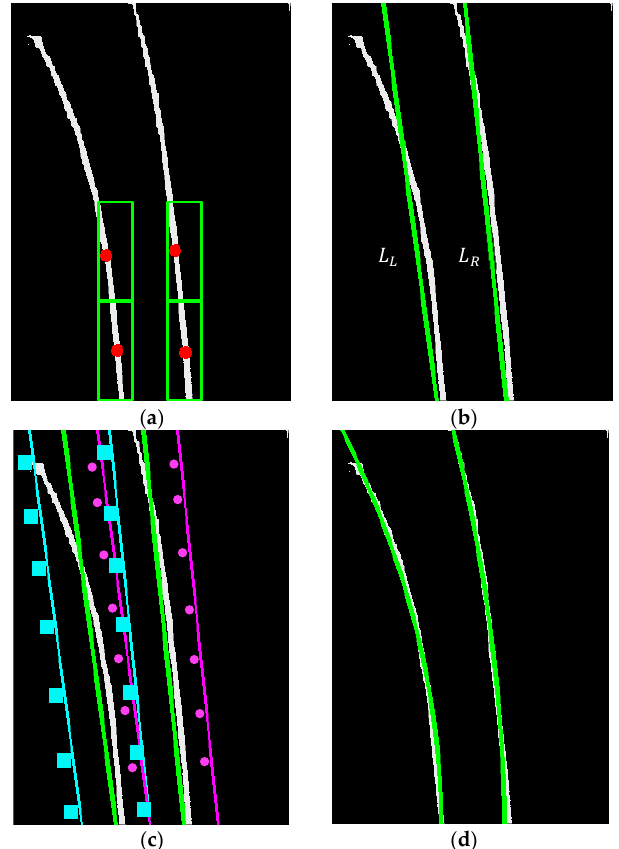
Figure 4. Illustration of ( a ) lane detection for the slope of the line segments 𝐿 (cid:3013) and 𝐿 (cid:3019) by the center points of the two windows at the left/right lane markings and ( b ) lane detection for line segments 𝐿 (cid:3013) and 𝐿 (cid:3019) from the base to the lane markings. Illustration of curve lane fitting by ( c ) the square lines for 𝐿 (cid:3013) and the dotted lines for 𝐿 (cid:3019) ( d ) by using the RANSAC parabola fitting.